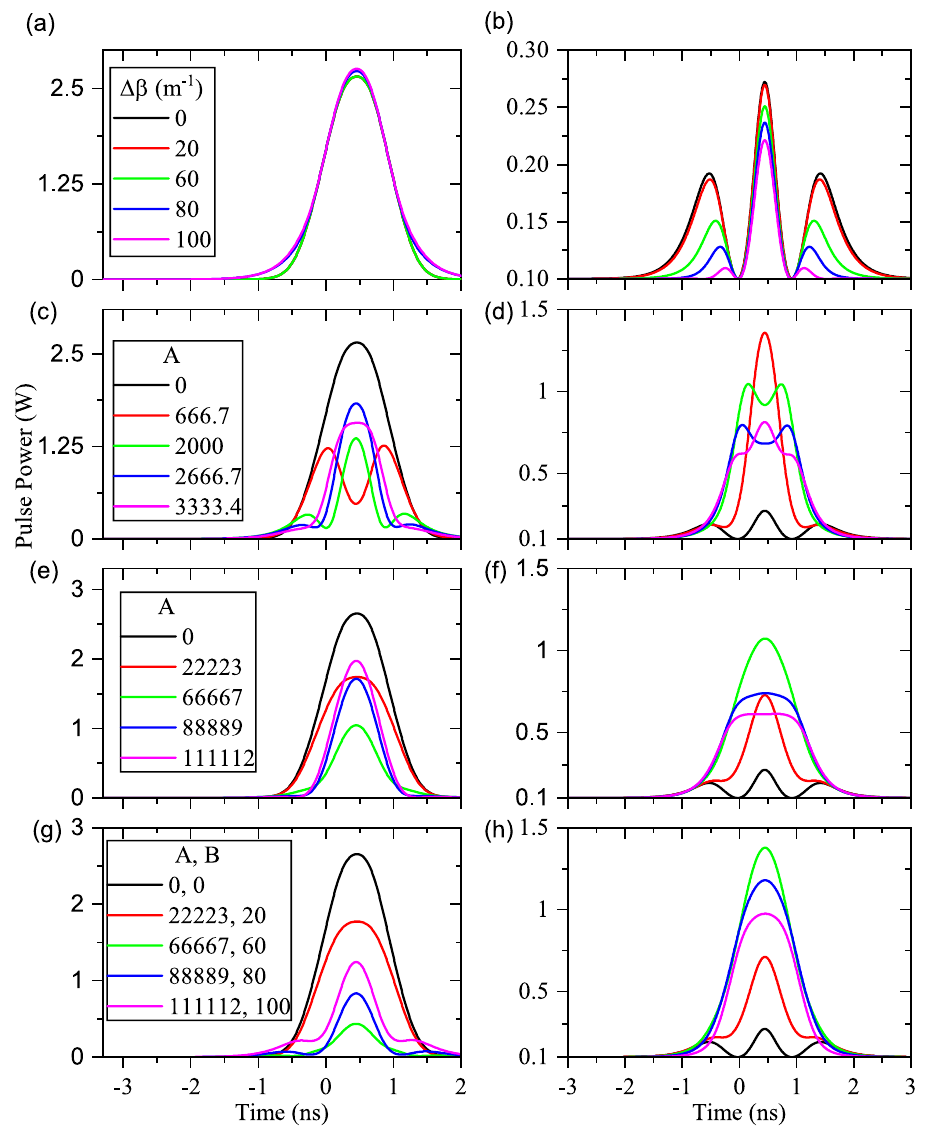
Figure 5. Effects of different types of waveguide inhomogeneity for the pulsed-DFG process. ( a ) and ( b ) depict the pump and signal/idler pulse shapes under the effects of constant inhomogeneity ( �β = 0, 20, 60, 80 , and 100 m − 1 ), respectively. ( c ) and ( d ) respectively, are the pump and signal/idler pulse shapes, under the effects of linear inhomogeneity ( �β = A ( x − 0.03 ) ). ( e ) and ( f ) are the pump and signal/idler pulse shapes, respectively, 2 when �β changes quadratically ( �β = A ( x − 0.03 ) ). ( g ) and ( h ) represent the pump and signal/idler pulse 2 + B shapes, respectively, when �β changes upside-down quadratically ( �β = − A ( x − 0.03 )